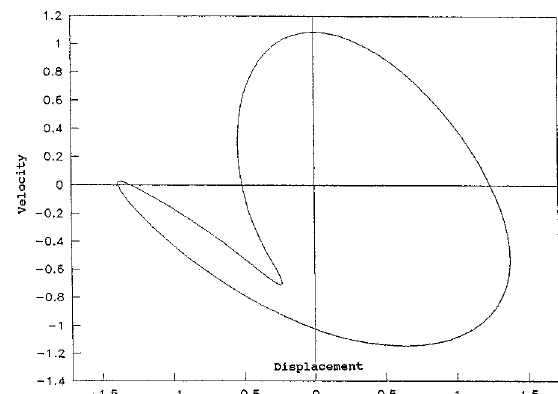
Fig. 5c. Phase diagram q = 0 : 287360 (times integration fails).